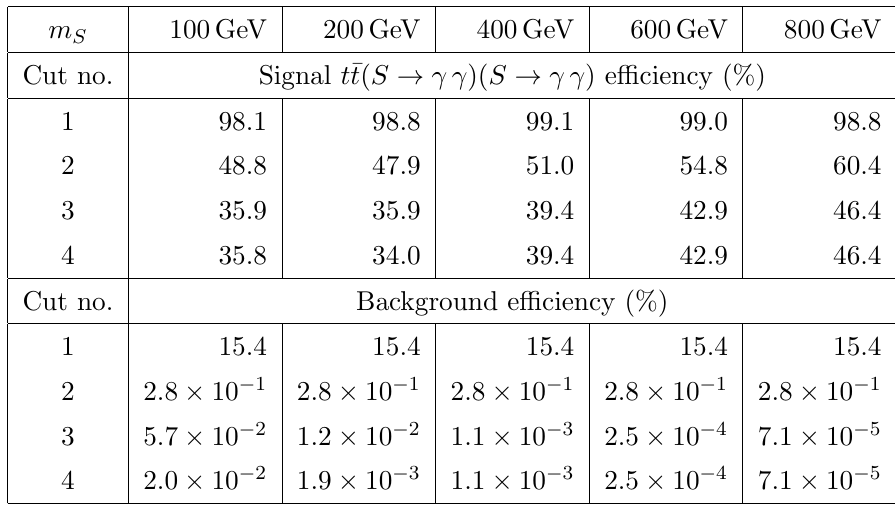
Table 3 . Signal and background e(cid:14)ciencies in percent following the cuts listed in table 2, for the (cid:13) (cid:13) SR and m t 0 = 1000